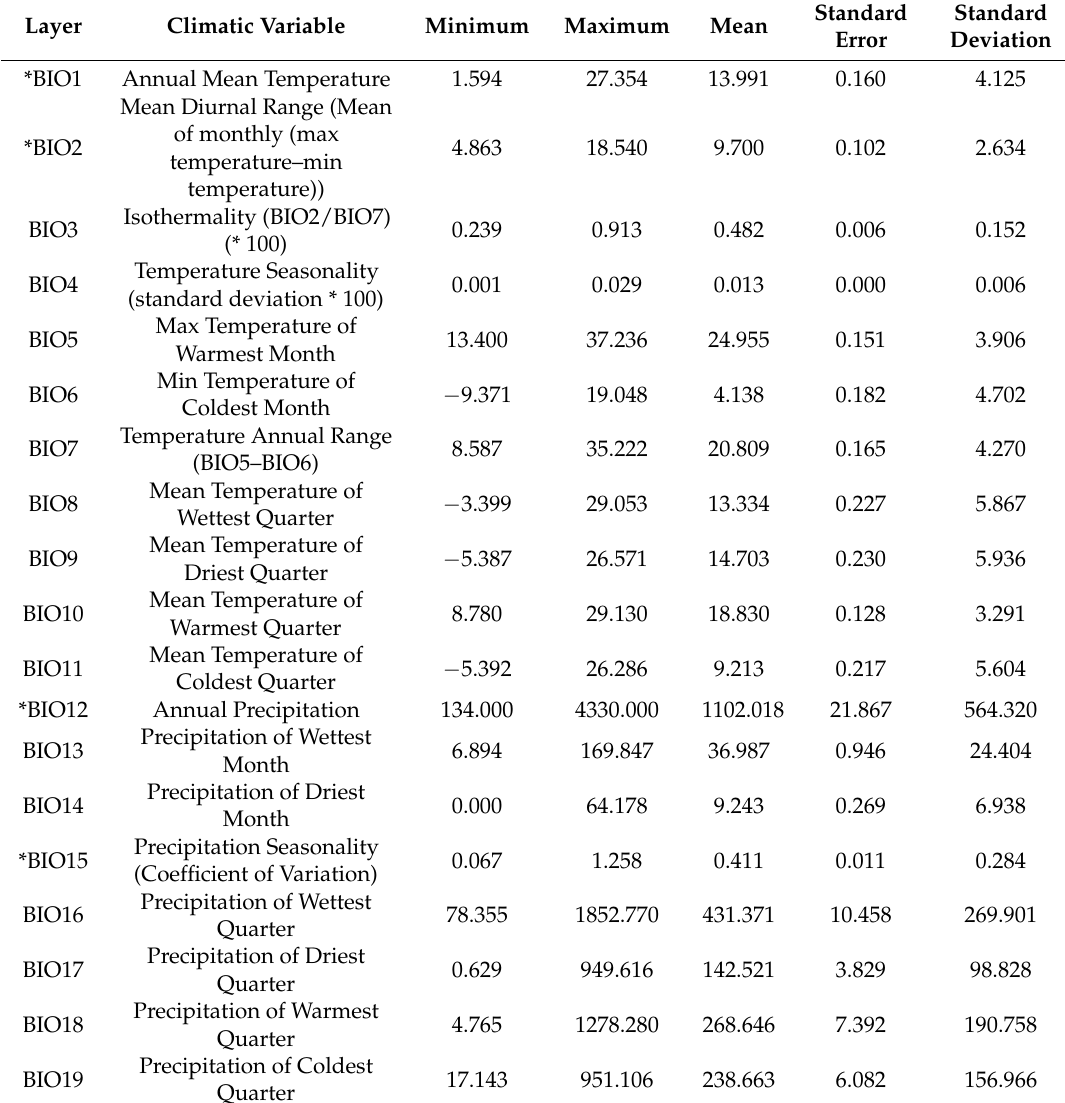
Table 2. Values of Bioclim measured at the occurrence